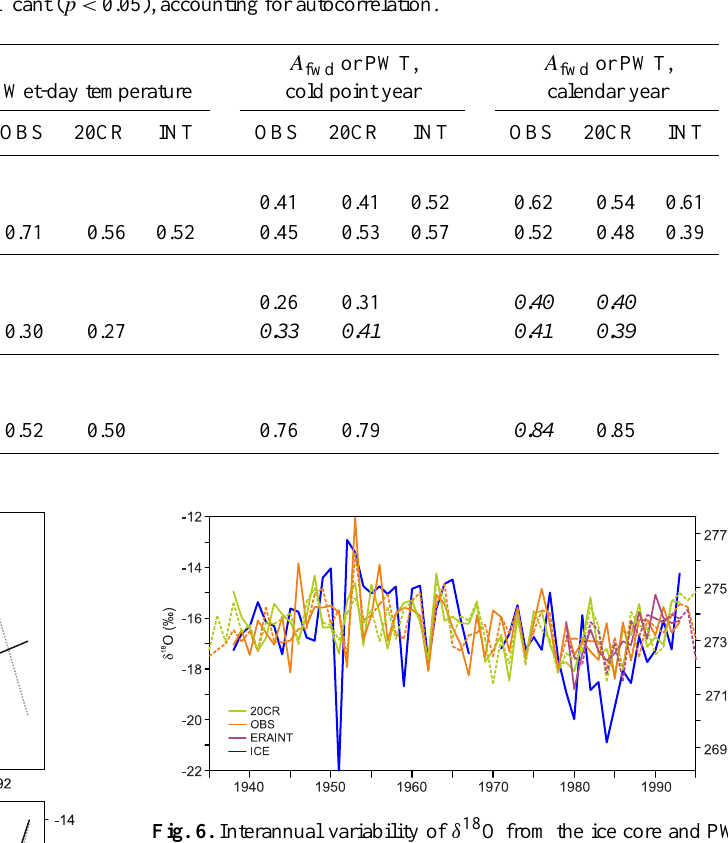
Table 1. Pearson correlations between accumulation and δ 18 O from the Grenzgletscher ice core with annual averages of temperature and precipitation, wet-day temperature, and accumulation and precipitation-weighted temperature (PWT) from the forward model. Different data sets are used (OBS=station observations, 20CR=Twentieth Century Reanalysis, INT=ERA-Interim). Also shown are correlations for 5